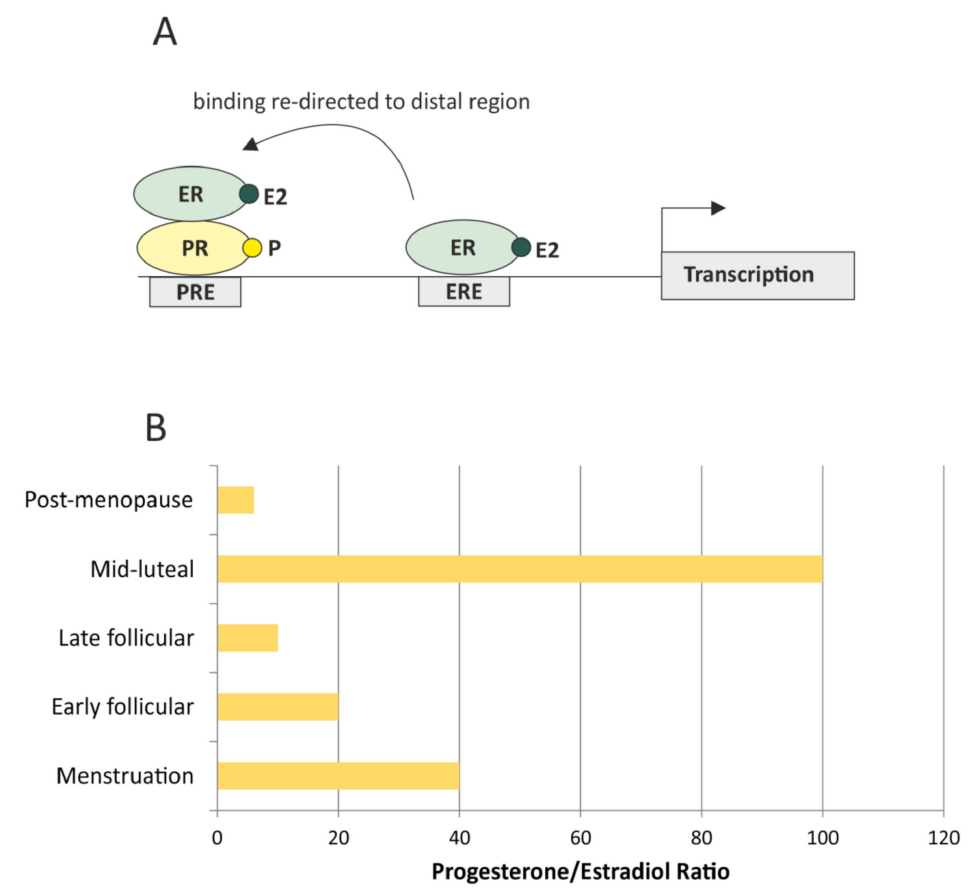
Figure 1. Estrogen receptor (ER) chromatin binding is re-programed in a presence of progesterone-bound progesterone receptor (PR). ( A ) In the presence of estradiol, ER binds to estrogen-responsive elements (ERE) in a proximal region of the promoter, but in a presence of both hormones, estradiol and progesterone, hormone-bound receptors form a complex which binds to more distal progesterone-responsive elements (PRE), re-programing the transcription profile. ( B ) The progesterone / estradiol ratio changes depending on the phase of menstrual cycle, assuming the lowest numbers in post-menopausal women (approximate ratio based on a data from The Global Library of Women’s Medicine). The ratio may influence the transcription profile due to a regulation described